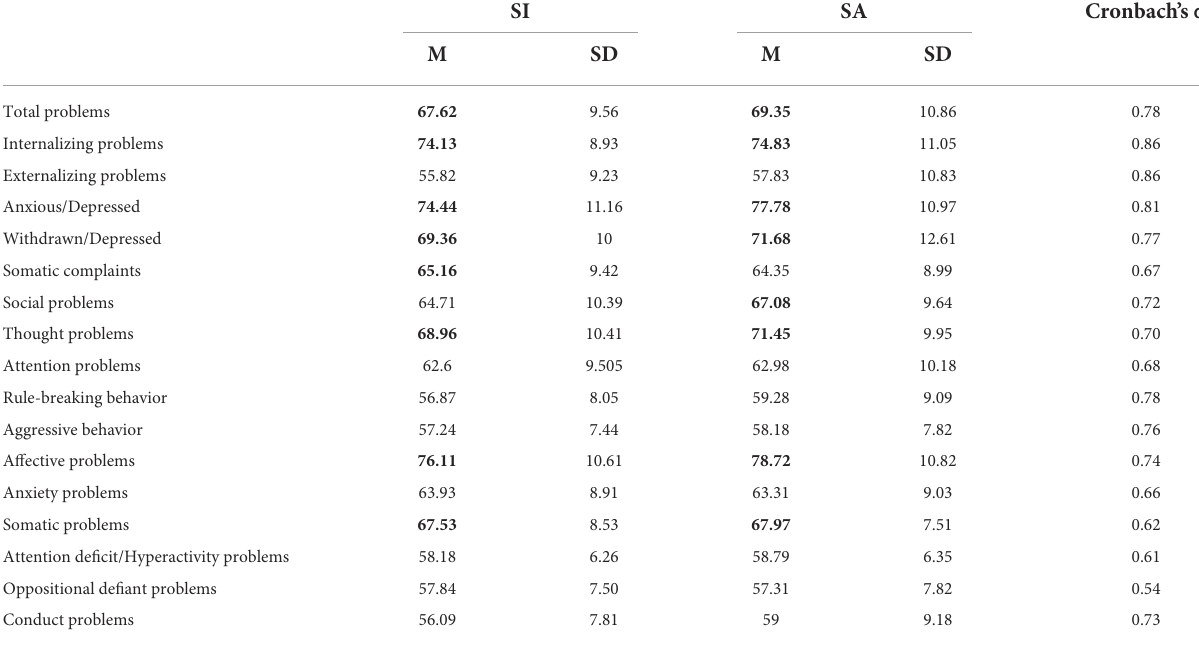
TABLE 3 Psychological characterization of the two groups using YSR 11-18 questionnaire.